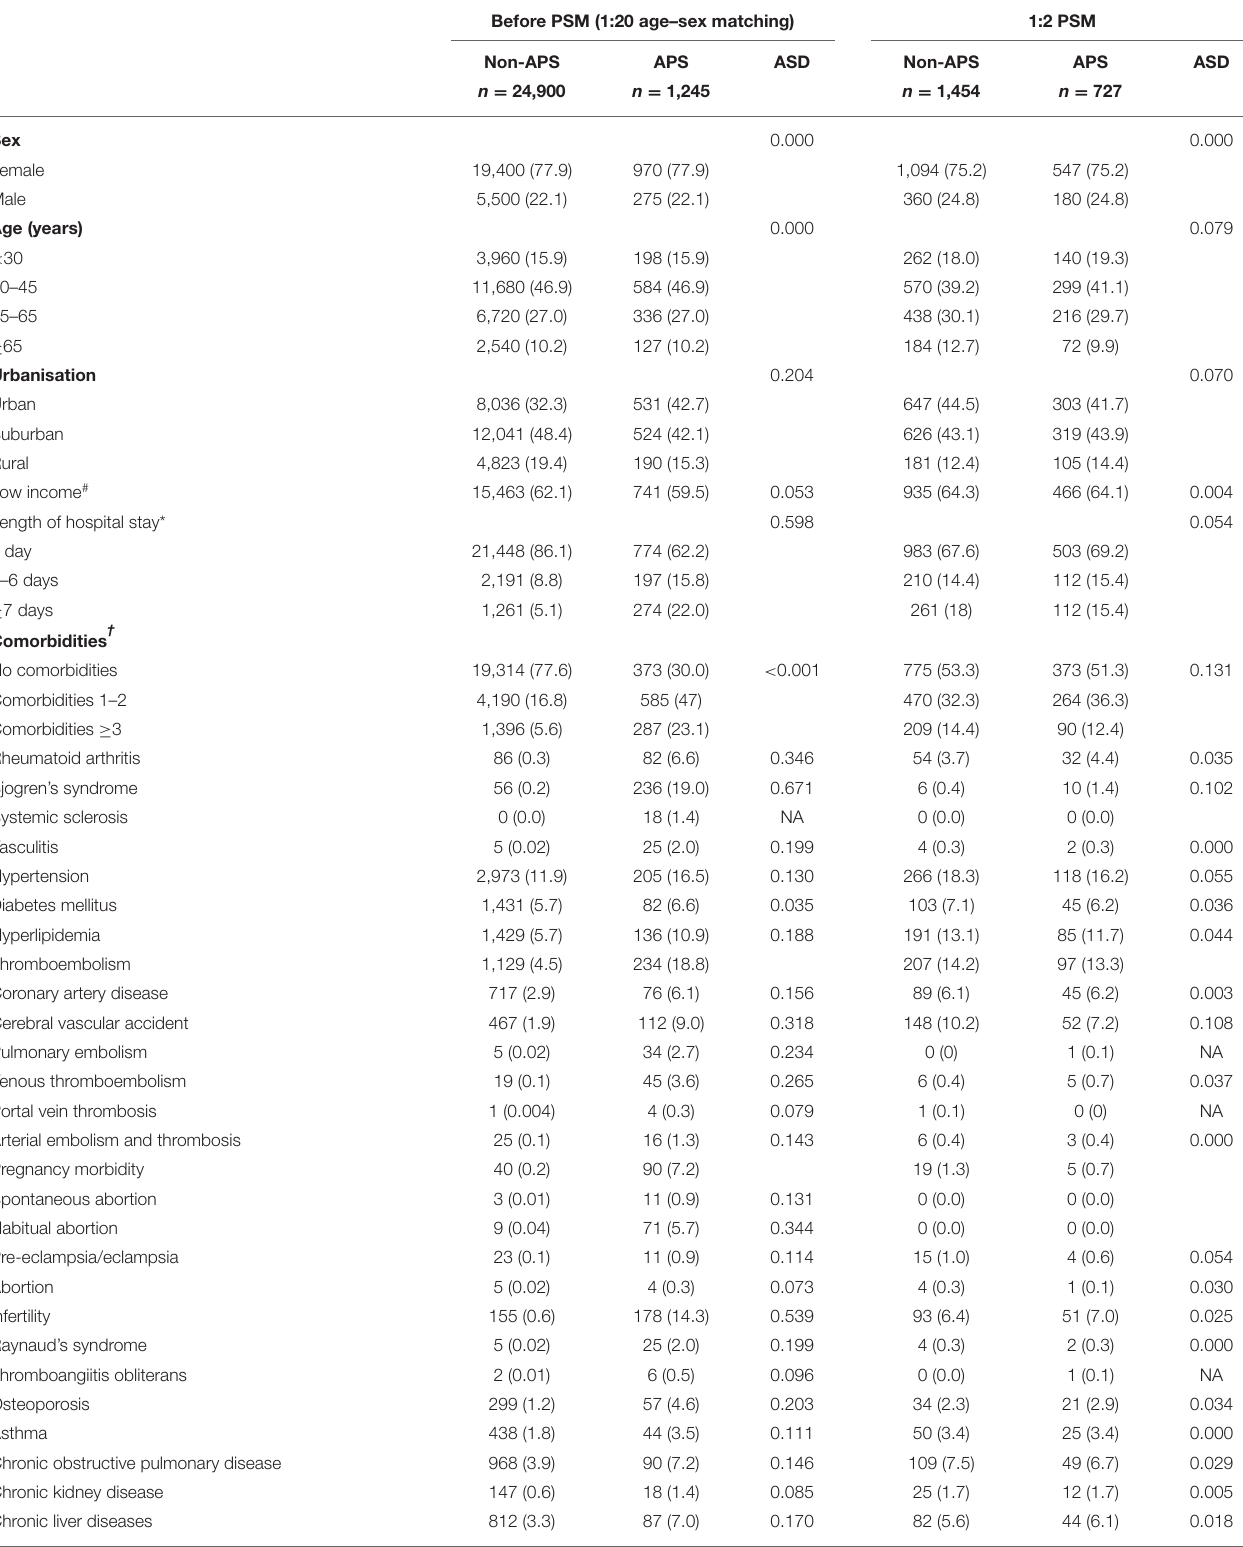
TABLE 1 | Baseline characteristics in the APS and non-APS groups.